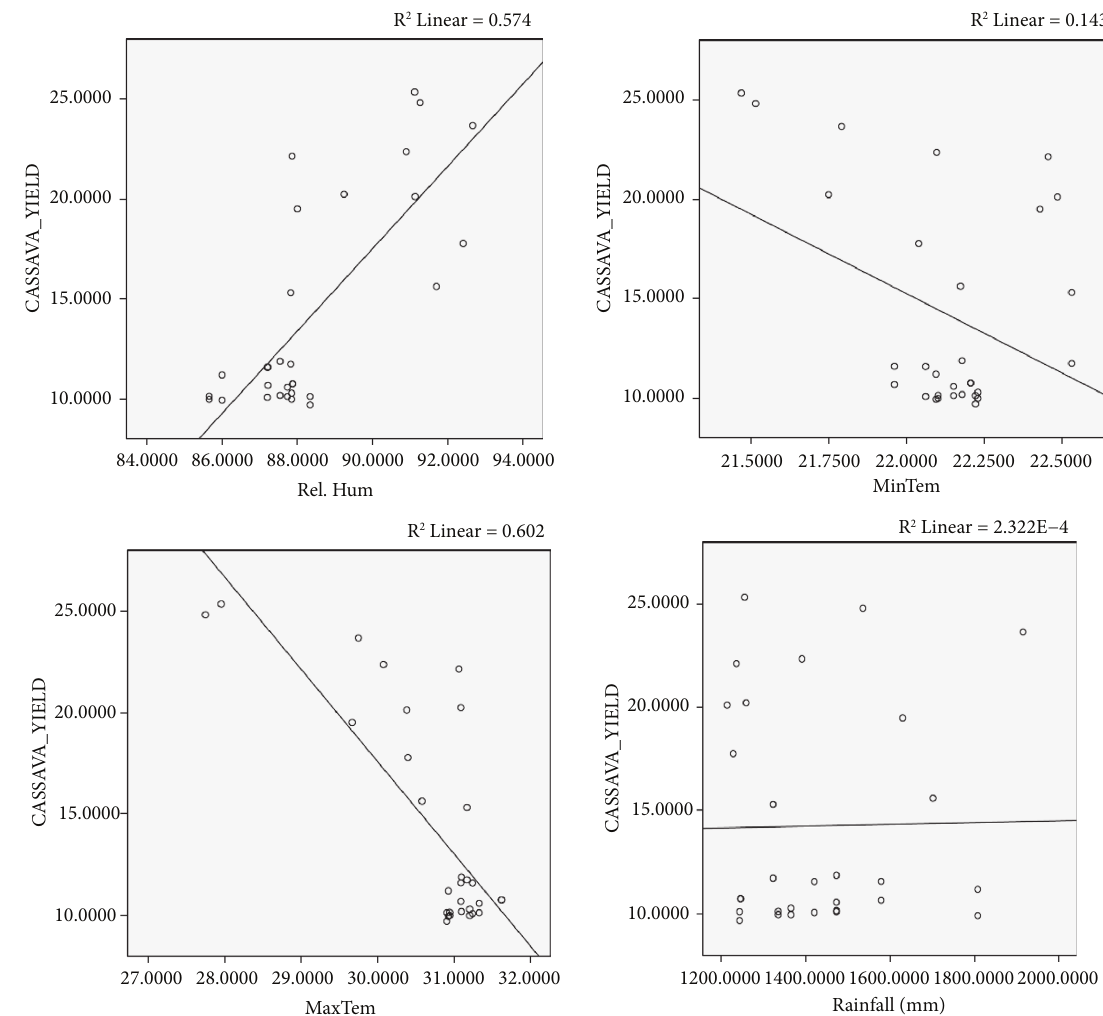
Figure 7: Scatter plot of cassava yield on each climatic